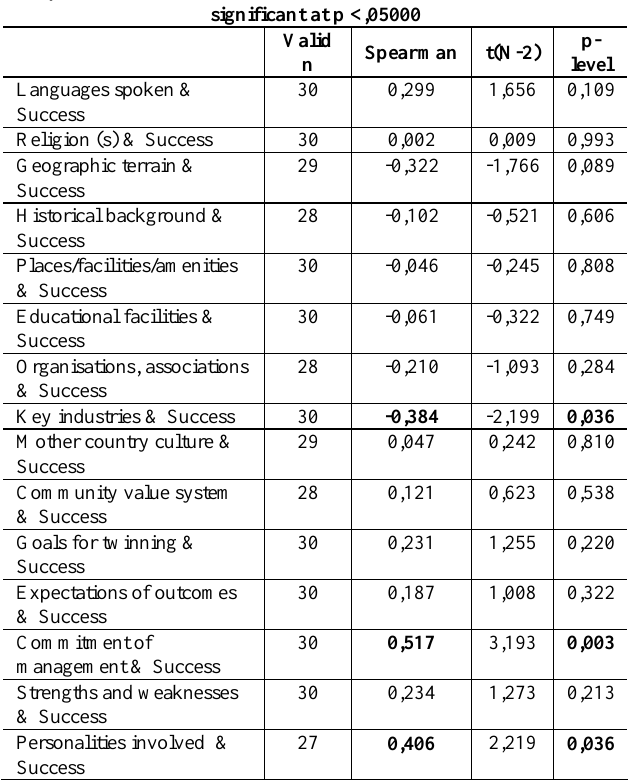
Table 11: Similarity and alliance success Spearman Rank Order Correlations Marked correlations are